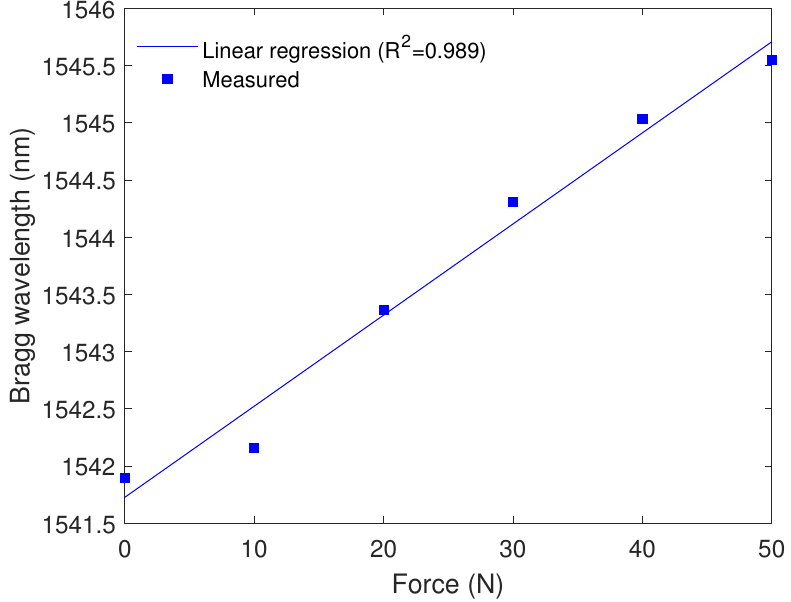
Figure 10. Bragg wavelength as a function of the force applied to the beam. The FWHM analysis enabled the evaluation of the strain distribution on the